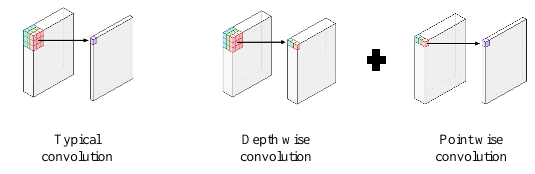
Figure 1. Comparison of typical convolution and depth-wise separable convolution